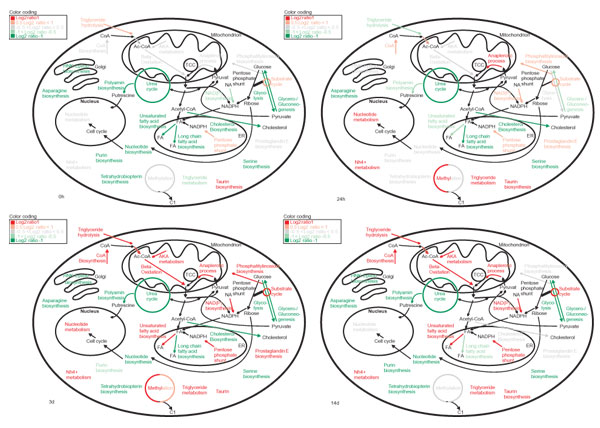
Temporal activation of metabolic pathways. Summarized is the activation of metabolic pathways at different time points (0 hours, 24 hours, 3 days, and 14 days) during fat cell differentiation. Color codes are selected according to expression levels of key enzymes in these pathways at distinct time points (red = upregulated; green = downregulated).